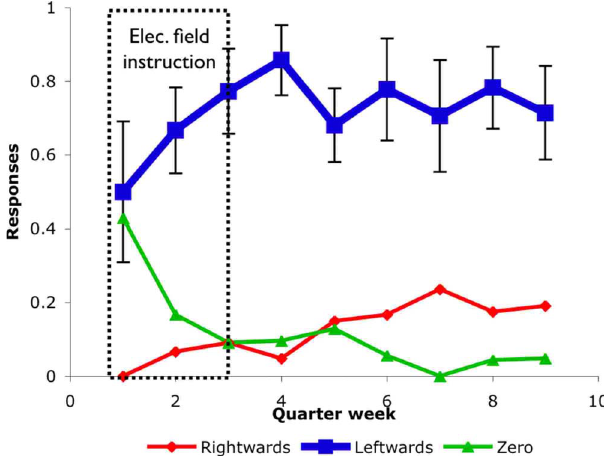
FIG. 3. (cid:1) Color online (cid:2) Responses to a question about the poten- tial between two positive charges. The correct answer (cid:1) blue and bold (cid:2) increases in the middle of the quarter but decays afterward. Some minor responses have been